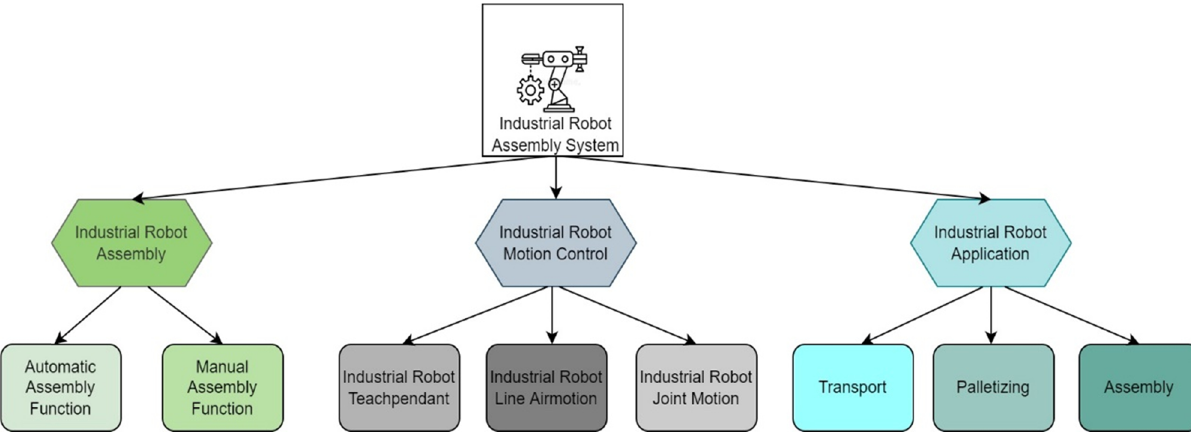
Figure 2: Functional modules of industrial robot assembly and adjustment system.